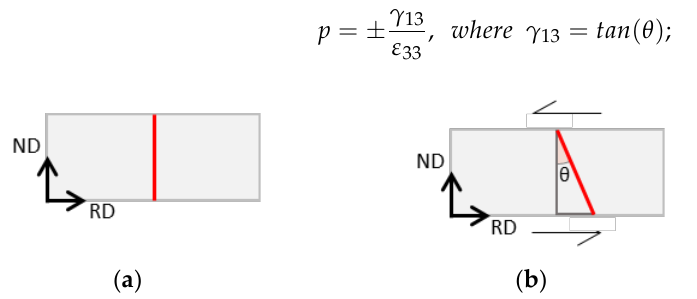
Figure 4. Shear deformation scheme: ( a ) before rolling and ( b ) after asymmetric rolling. In the present work, the thickness reductions of 20% and 30% were considered. For a 20% reduction in thickness, the corresponding strain component in the normal